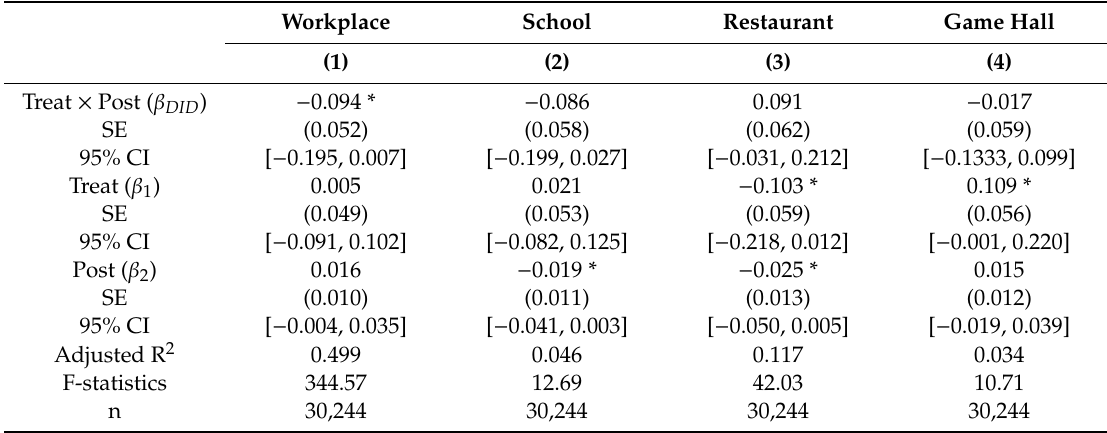
Table A1. The impact of a partial smoking ban on whether people “do not go there” (the probability of going to workplace, school, restaurant, game hall).